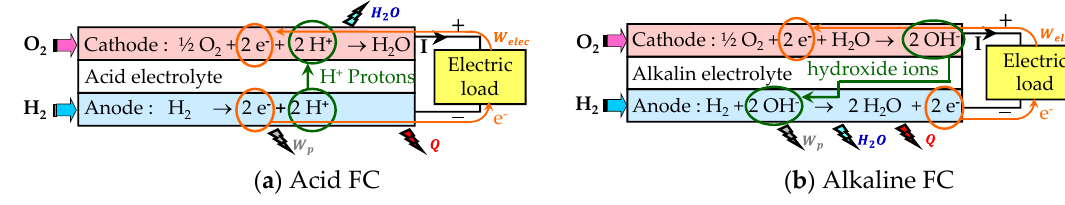
Figure 2. Oxidation-reduction reactions in the fuel cell (FC).